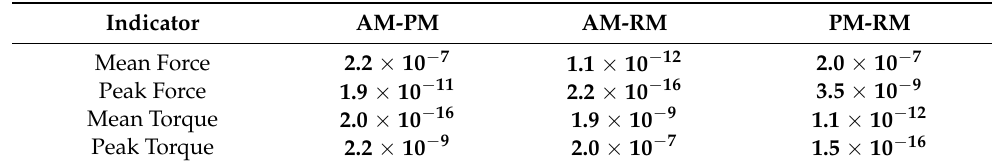
Table 4. Obtained p -values after pairwise comparisons of physical interaction parameters using posthoc